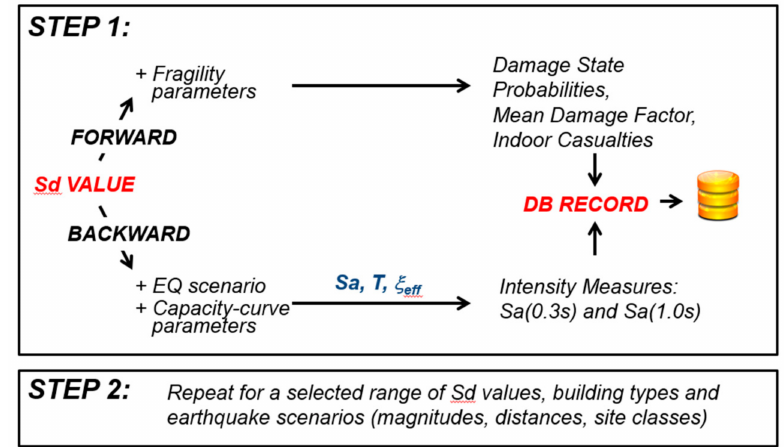
Figure 1. Flow chart of the development of ER 2 . Sd: spectral displacement; DB: data base; Sa: spectral acceleration; T: natural period; ξ eff : effective damping